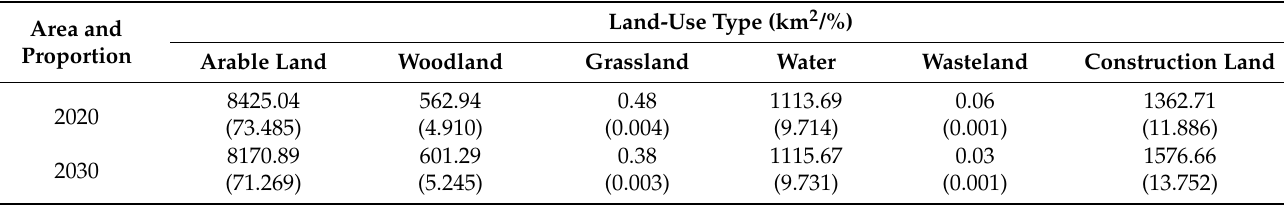
Table 1. Land-use area and percentage in